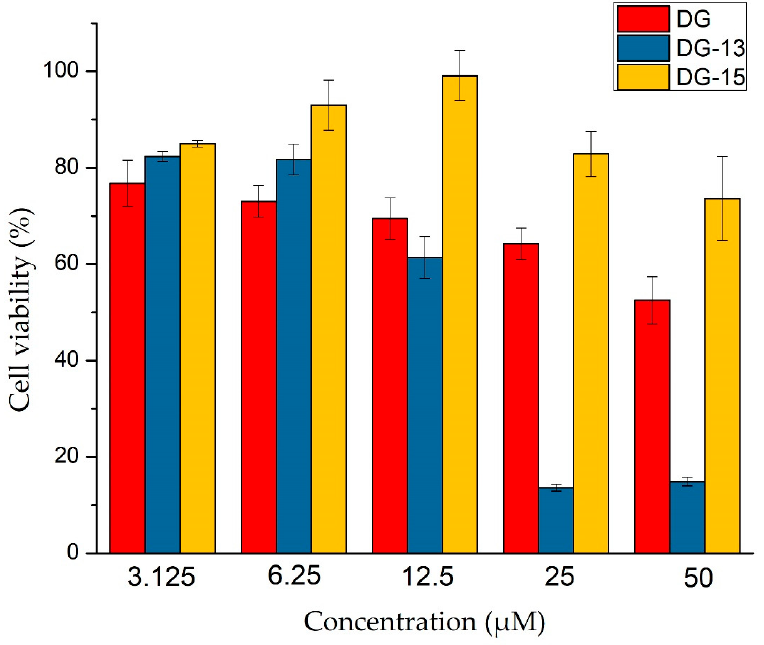
Figure 1. Cytotoxicity of diosgenin derivatives on H9c2 for 24 h. Data were expressed as cell viability based on three independent experiments ( n = 3).